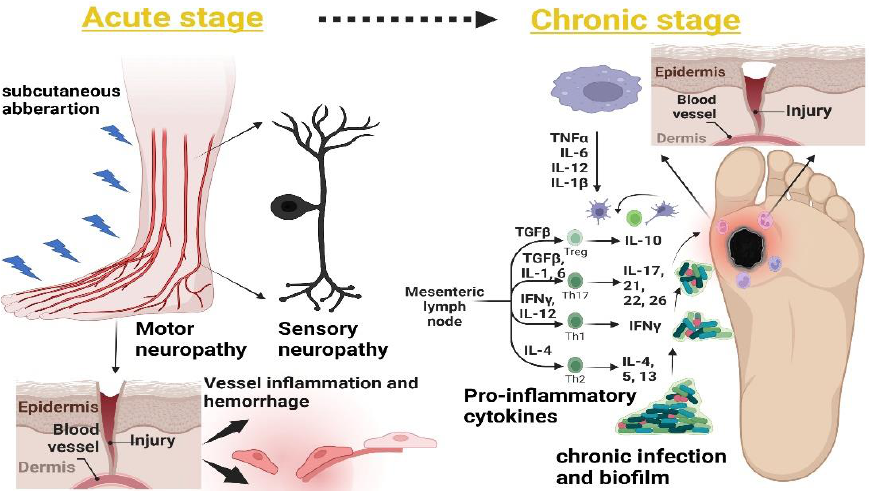
Figure 1. Acute and chronic conditions of the DFU. The acute stage includes subcutaneous aberration, which is associated with loss of sensation at the distal part of the wound. The continuous aberration at the wound causes blood vessel angiogenesis to fail, resulting in inflammation at the wound site ( left ). The chronic stage is characterized by continuous wound damage and the movement of proinflammatory responses. This causes skin moistening, which allows opportunistic pathogens to form a biofilm, delaying the wound-healing mechanism during a DFU ( right ).